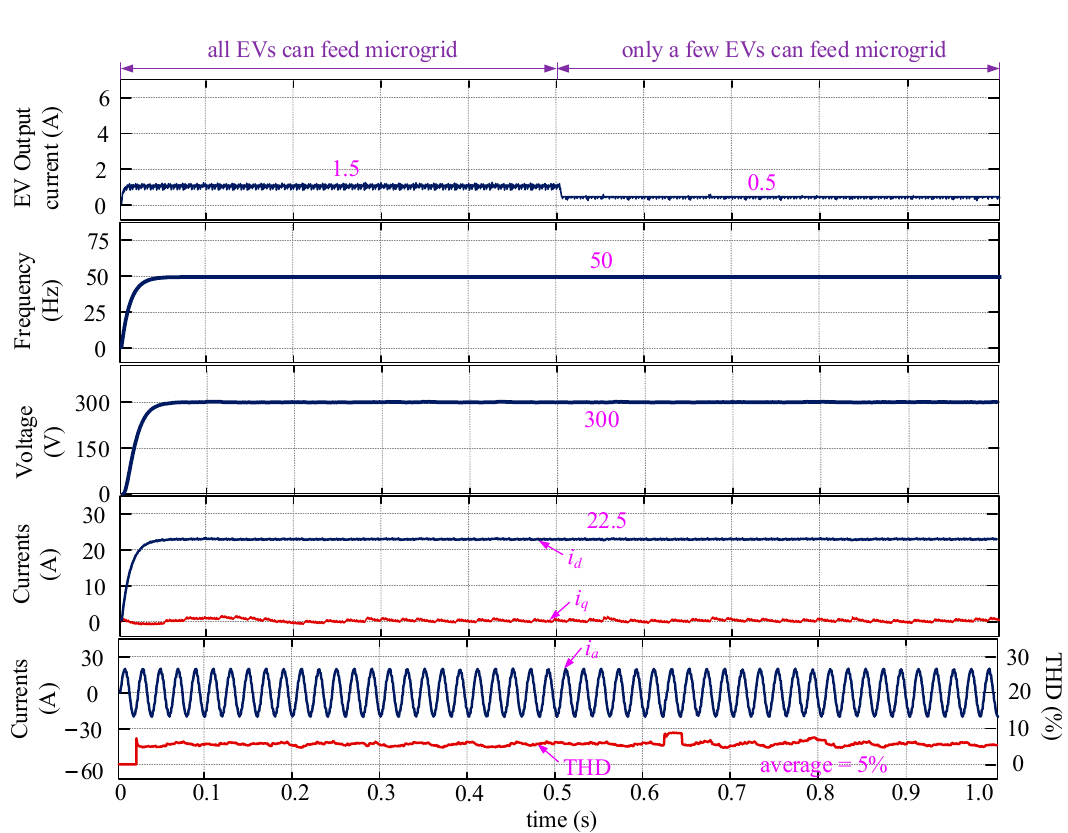
Figure 9. Control performance of the proposed DCL method with EV uncertainties considered.